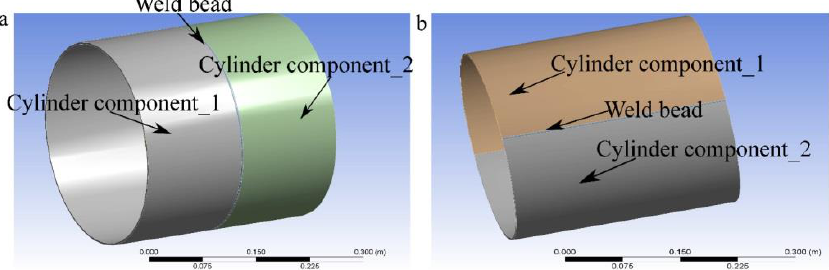
Fig. 2. 3D FE models of a) circumferential and b) longitudinal welds of cylindrical